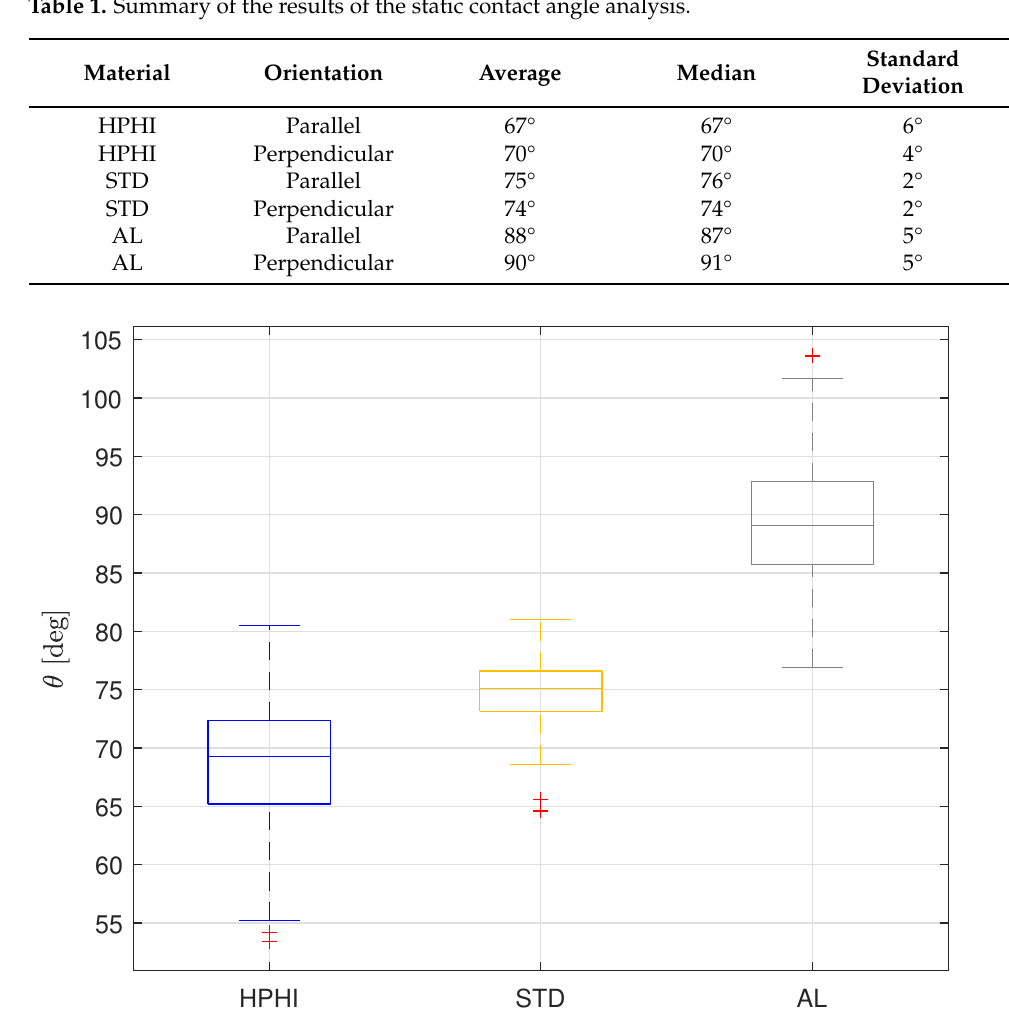
Table 1. Summary of the results of the static contact angle analysis.